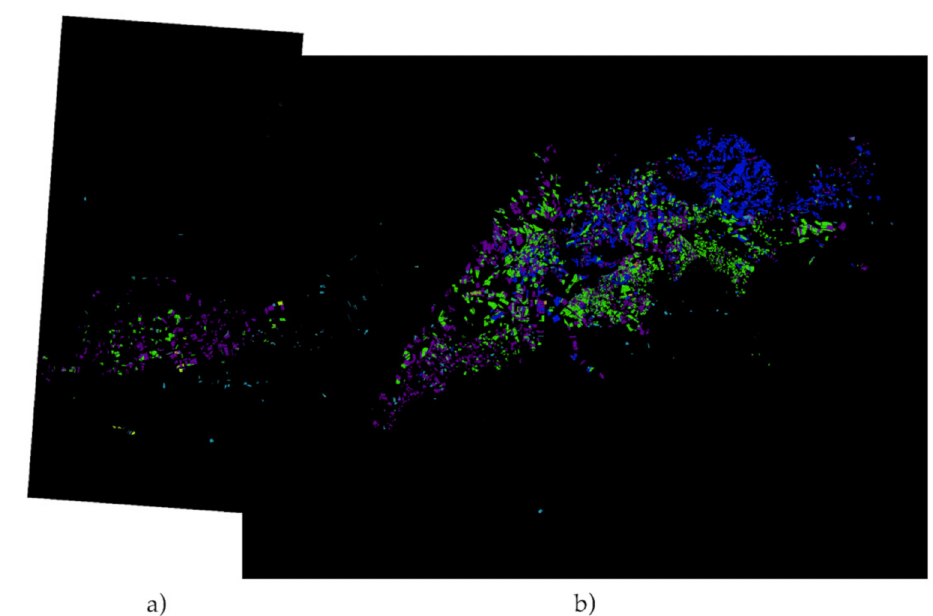
Figure 18. PredictedovertheexpectedmaskofZone29( a )and30( b ). M é ridaandDonBenito, Extremadura.